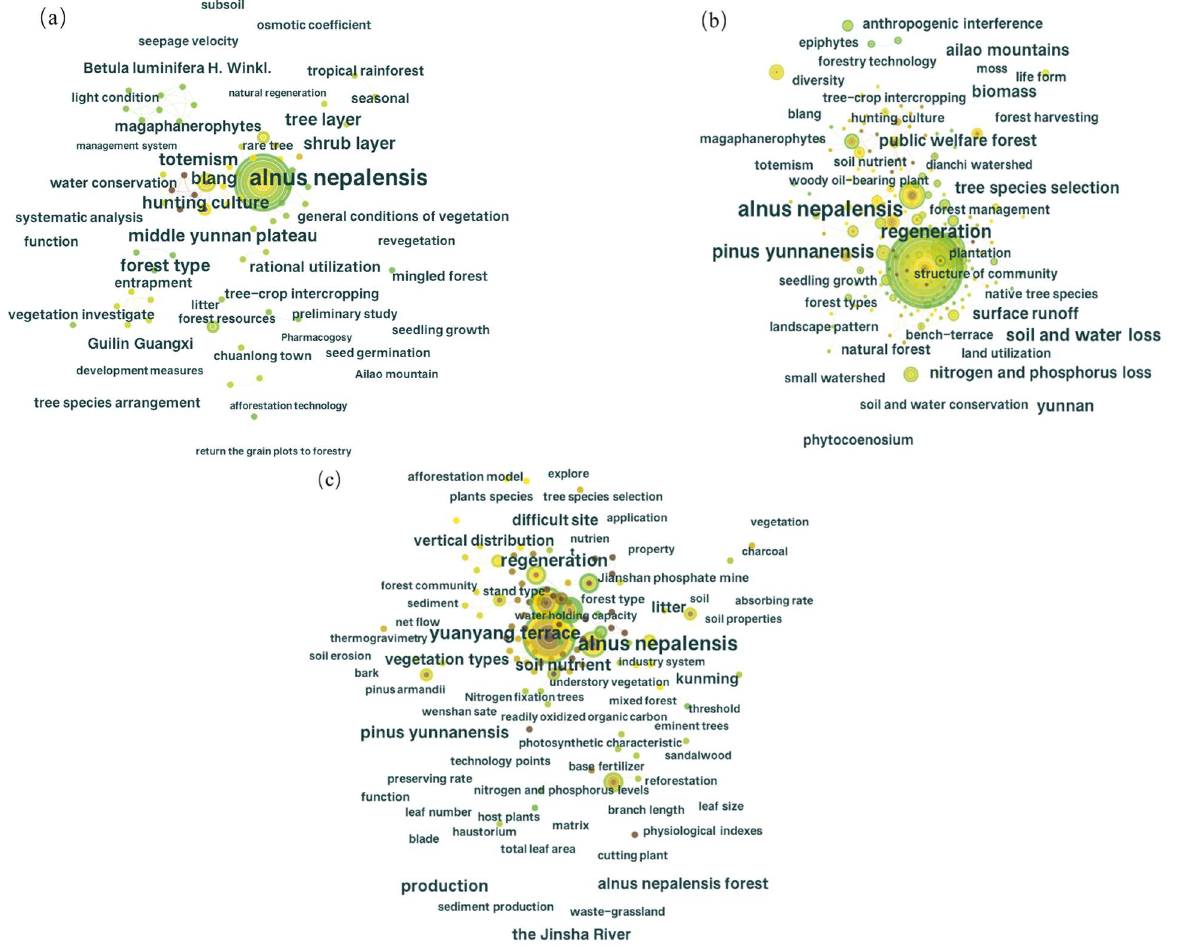
Figure 5. Keywords network map for Nepalese alder in different development stages. ( a ) Initial development, ( b ) fast development, ( c ) high-quality development.